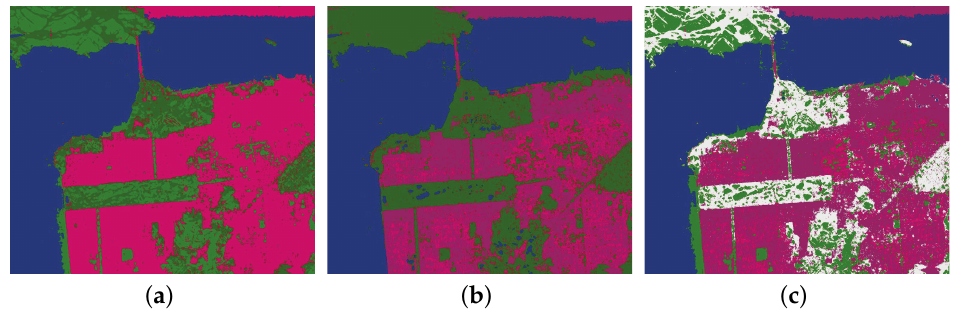
Figure 9. Classification results with different block sizes. ( a ) Result with block size as 75. ( b ) Result with block size as 90. ( c ) Result with block size as